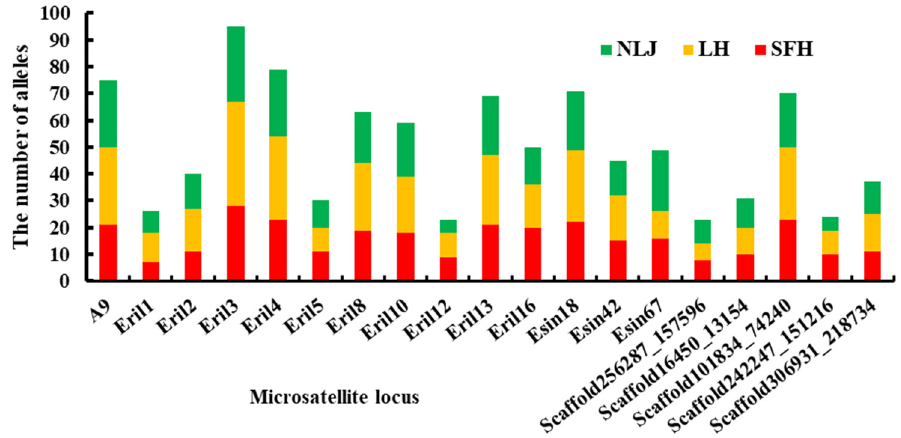
Figure 2. Number of alleles for each microsatellite locus in Eriocheir s. s. populations. Green, yellow, and red colors represent the Nanliujiang River (NLJ), Liaohe River (LH), and Suifenhe River (SFH) populations, respectively.